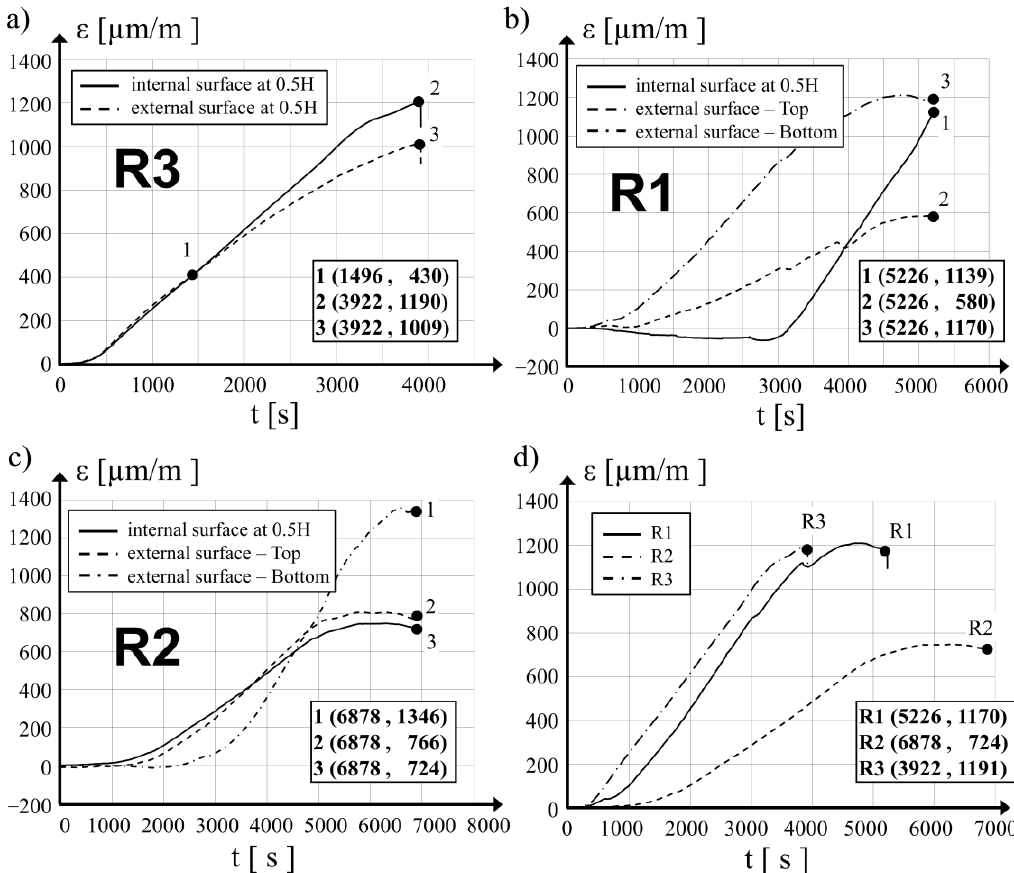
Figure 8. Development of vertical average strains during the tests: ( a ) for hollow cylinder R3, ( b ) for hollow cylinder R1, ( c ) for hollow cylinder R2, ( d ) at the internal surface of the three cylinders at their mid-height points.